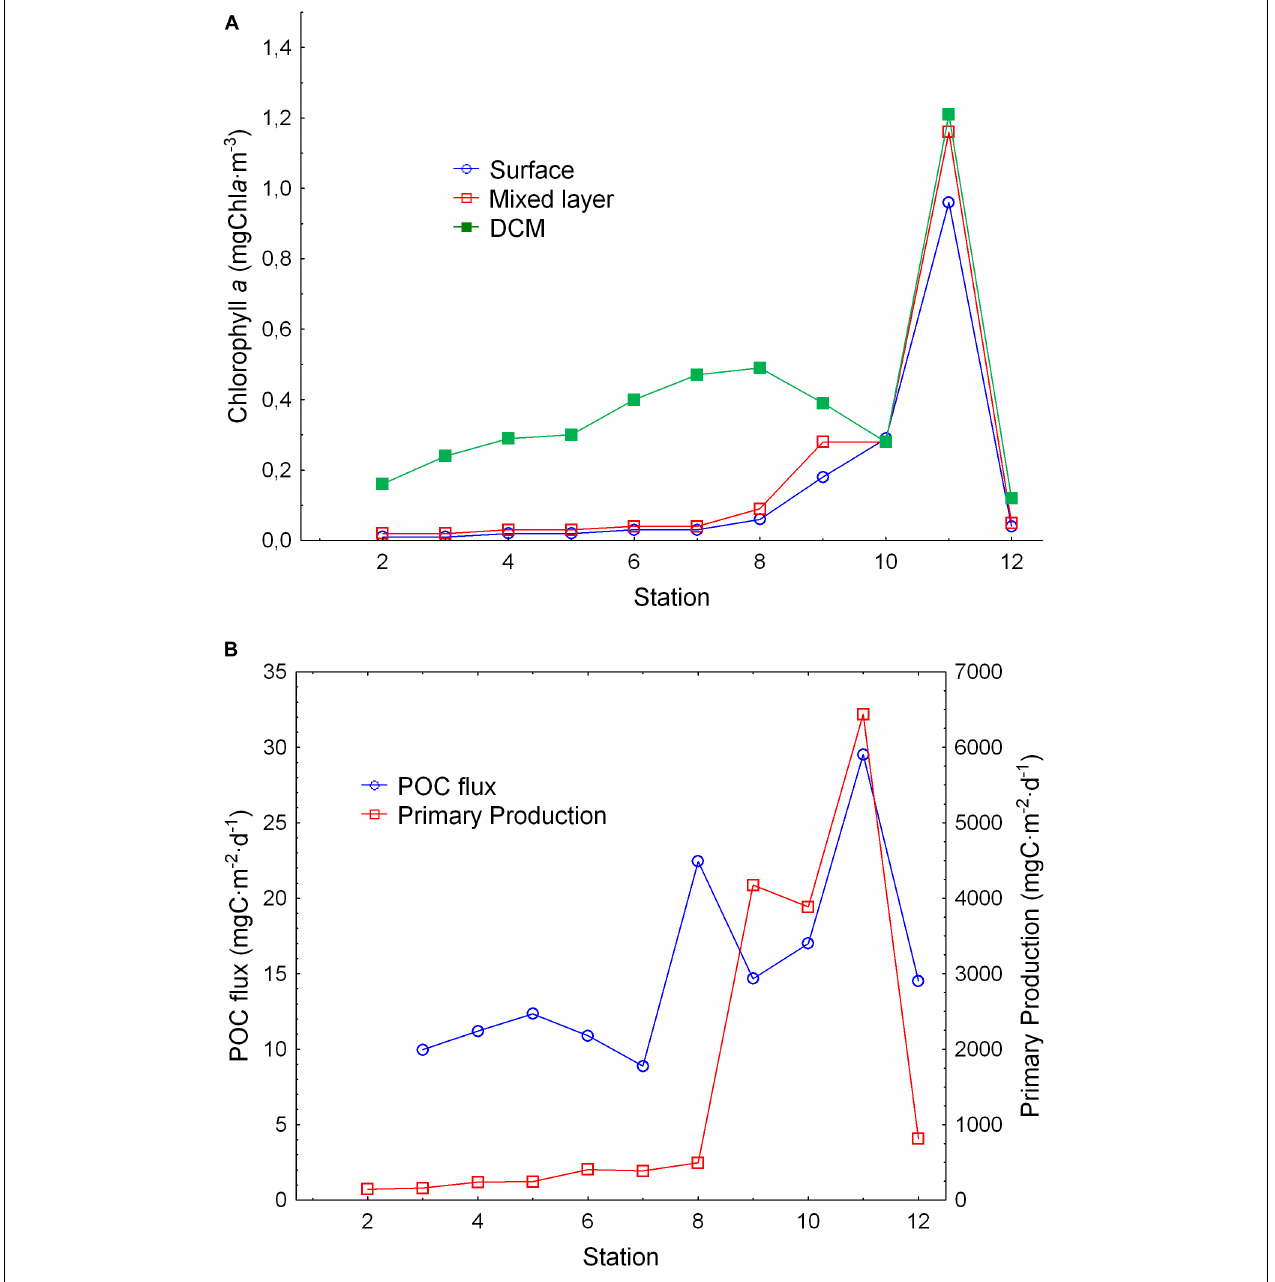
FIGURE 3 | (A) Chlorophyll at the surface (empty dots), mixed layer (empty squares), and at deep chlorophyll maximum (full squares). (B) POC flux (dots) and primary production (squares) obtained from remote sensing (VGPM model) along the transect performed during the